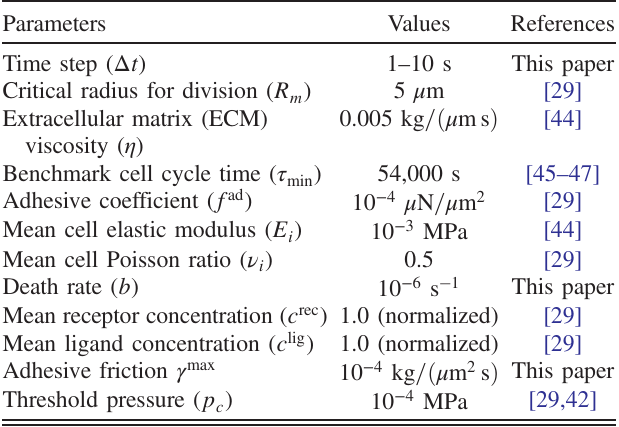
TABLE I. The parameters used in the